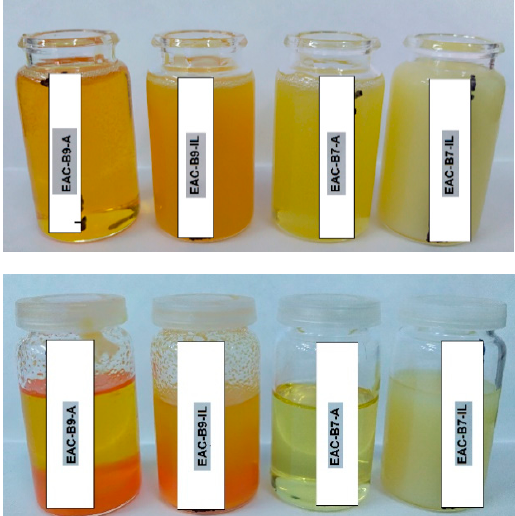
Figure 3. Images of EAC-BR compositions with LCAs right after the homogenization process (panel above ) and after 3 days (panel below ).